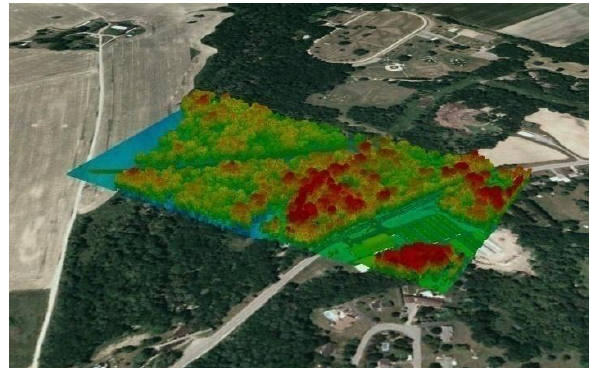
Figure 6 - LiDAR data over geo-referenced images (Avon,